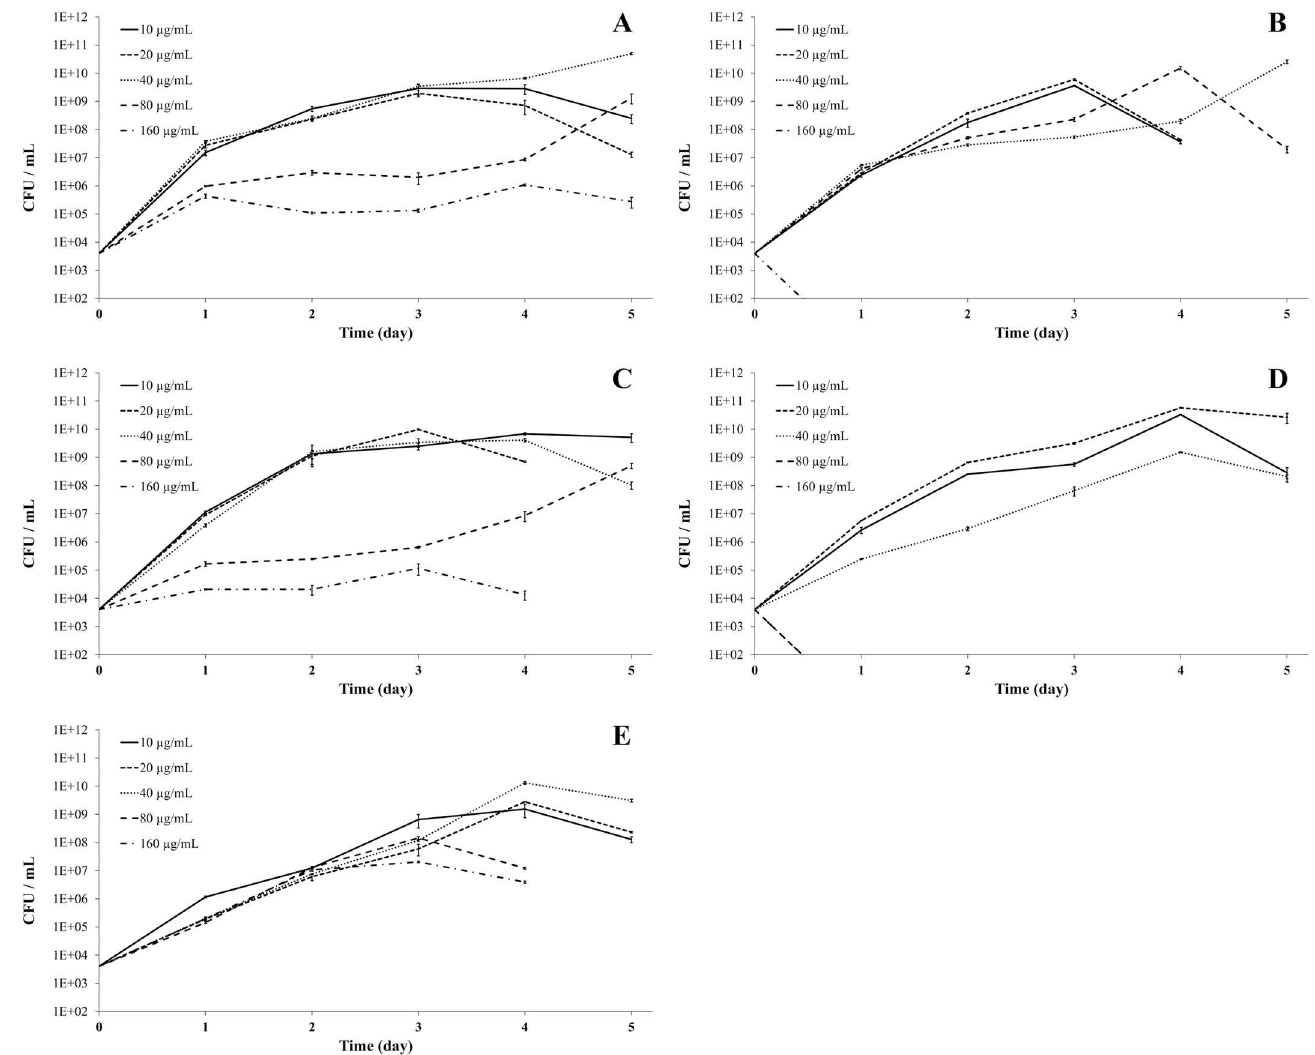
Fig 4. Growth of selected insecticide-degrading bacterial isolates obtained from the gut microbiota of insecticide-resistant lines of Spodoptera frugiperda at different insecticide concentrations (10, 20, 40, 80 or 160 μ g/mL). Isolates A) IIL-Cl29 ( Leclerciaadecarboxylata ), B) IIL-Lc09 ( Pseudomonas stutzeri ), C) IIL-Dm05 ( Arthrobacter nicotinovorans ), D) IIL-Sp19 ( Pseudomonas psychrotolerans ), and E) IIL-Luf14 ( Microbacterium arborescens ) were isolatedand cultivatedon insecticide-basedmedia containing, respectively,chlorpyrifos ethyl, lambda-cyhalothrin, deltamethrin, spinosadand